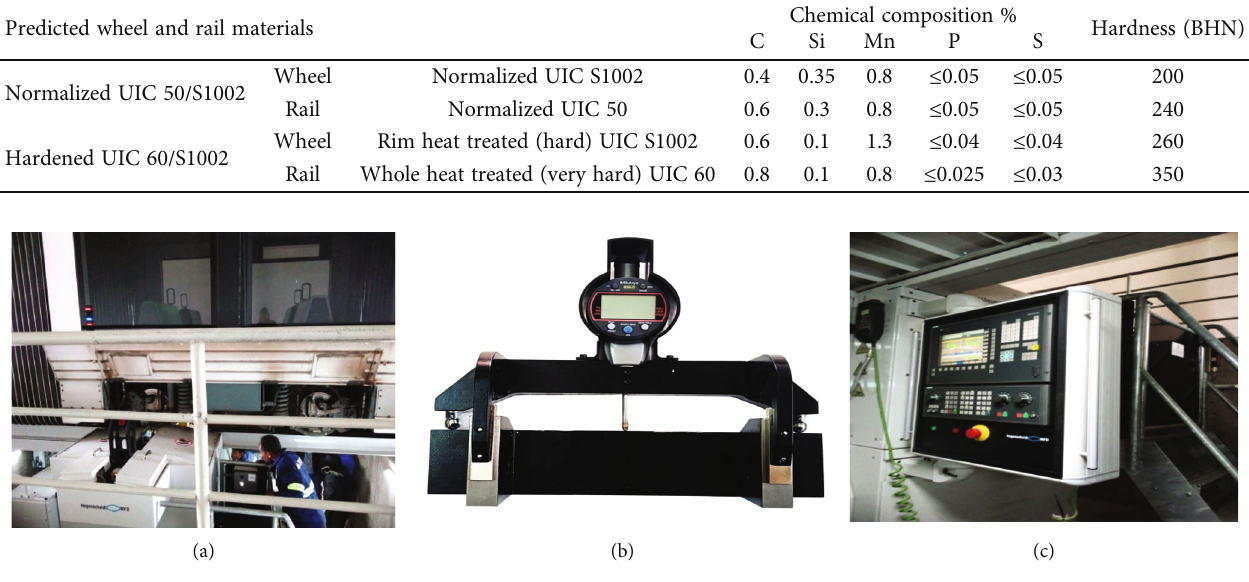
Figure 3: Railway wheel wear measurement of Addis Ababa Light Rail Transit (LRT). (a) Re-pro fi ling workshop, (b) dial type wheel diameter gauge, and (c) numeric display to show the wheel diameter value. Table 3: Addis Ababa light rail transit (LRT) — Ayat depot vehicles inspected between March 2017 and January 2017 vehicle. Vehicle